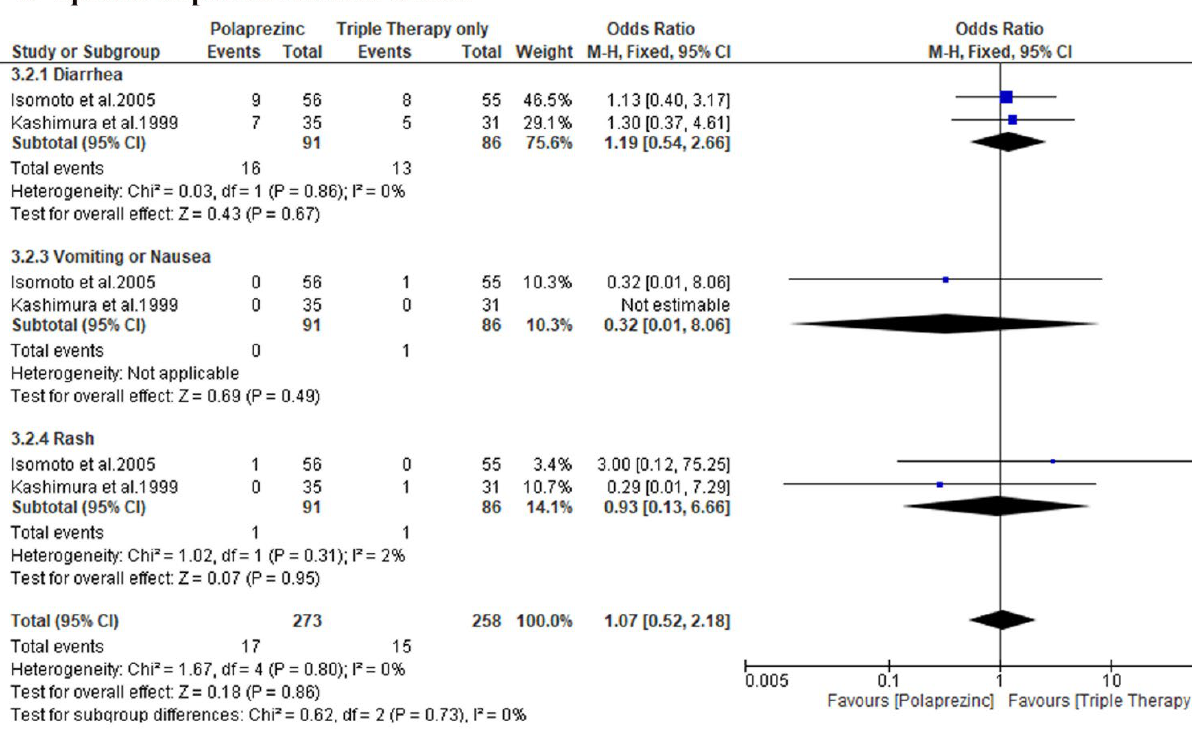
Figure 5. Forest plot of the secondary outcomes ( A ) total adverse events, ( B ) specific reported adverse events [50]. OR: odds ratio, CI: confidence interval.